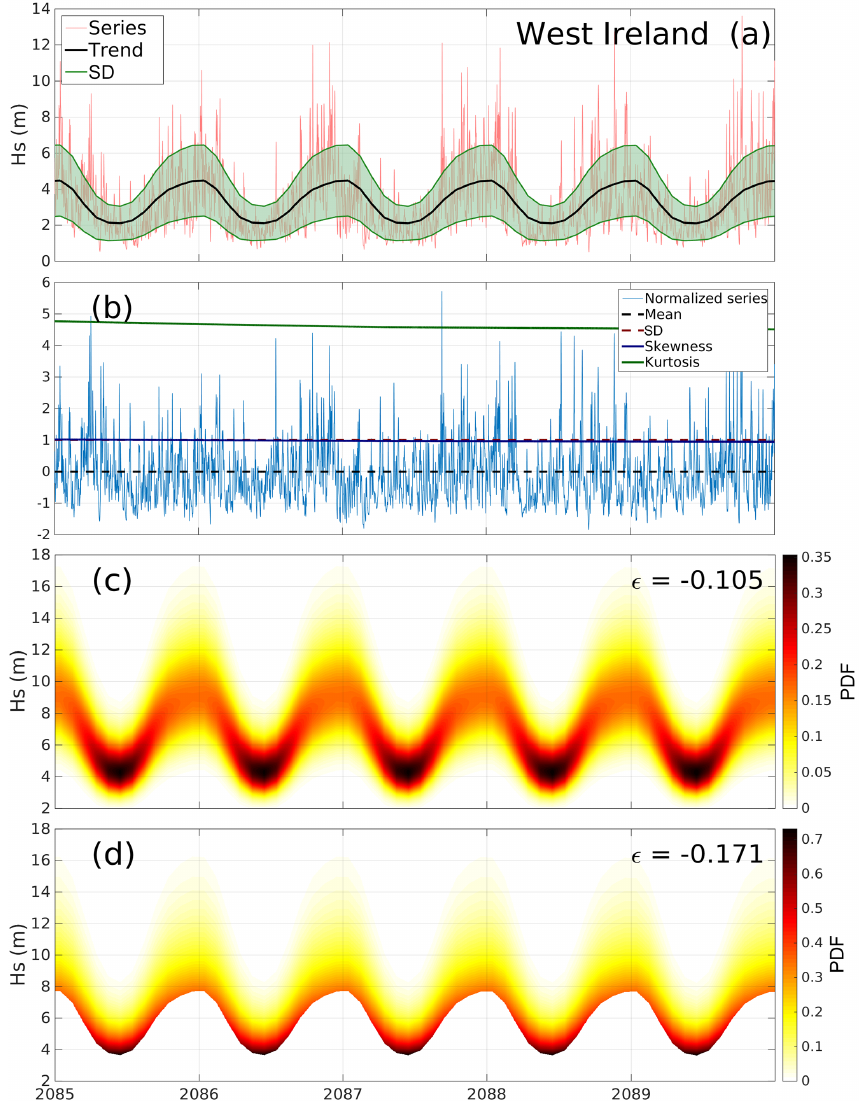
Figure 4. Seasonal analysis of the projections of significant wave height in west Ireland: (a) series, its trend, and standard deviation; (b) the normalized series with higher order statistical indicators; (c) non-stationary GEV of annual maxima; (d) non-stationary GPD of annual peaks. In (c) and (d) the values of the shape parameter ε best fitted for the GEV and GPD distributions are reported. For the sake of clarity, only a 5-year time slice is